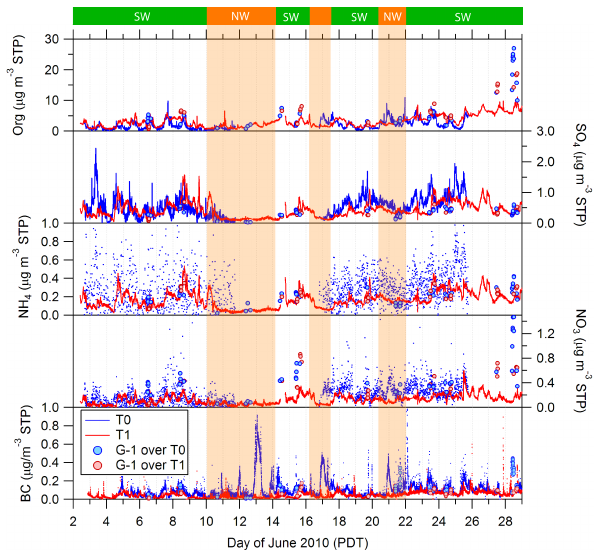
Fig. 7. Comparison of bulk aerosol species time series at T0 and T1 ground sites along with observations onboard the G-1 during overpasses at the respective